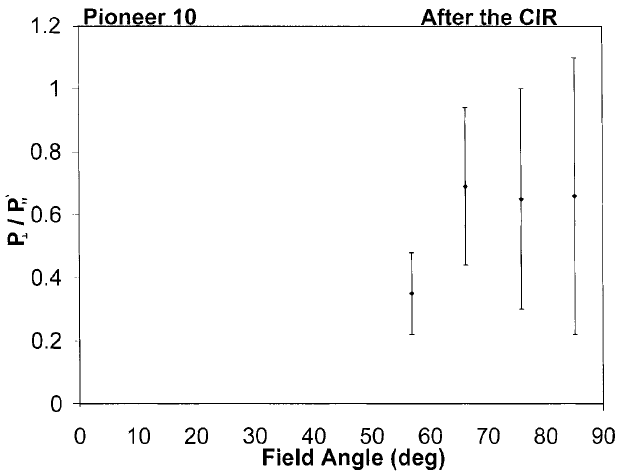
Fig. 5. Ratio P ? = P 0 as a function of the angle of the mean magnetic k field for the interval after the CIR